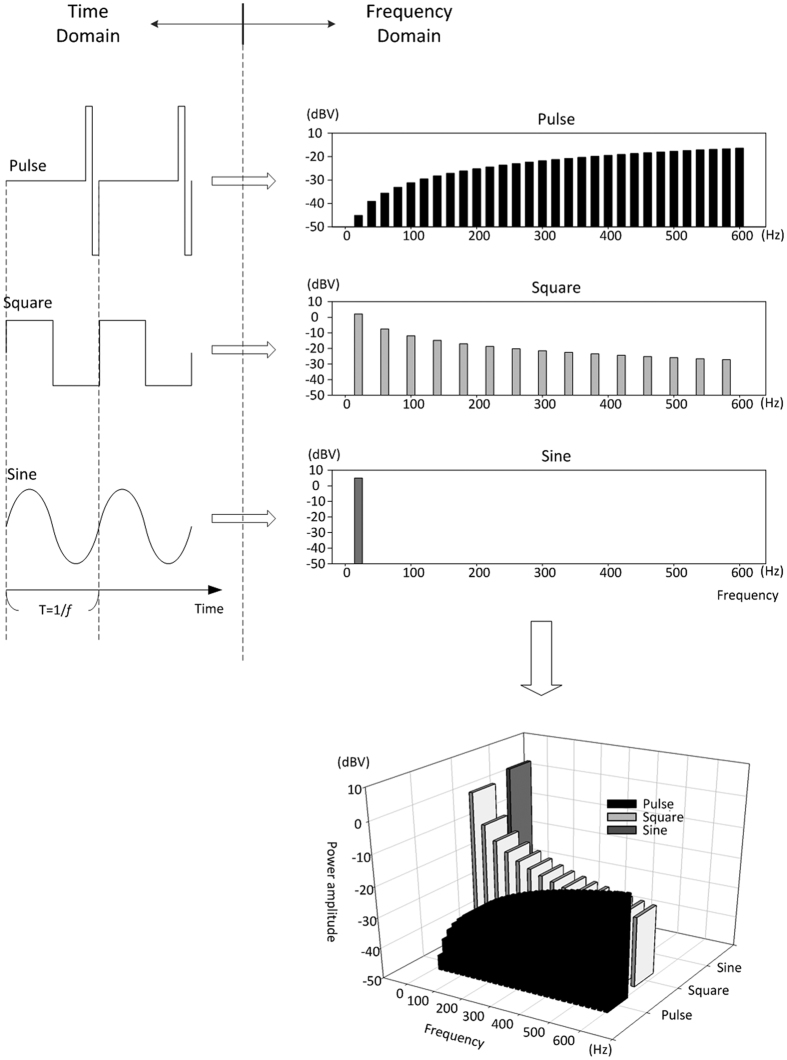
Harmonic analysis of pulse (pulse width = 250 μs, biphasic), square, and sine functions applied at the same frequency (20 Hz) but normalized intensities.Intensity of the square function is 1 Ampere, whereas intensities of pulse and sine functions are normalized such that the pulse, square, and sine functions carry the same amount of electrical energy during the same period of time. Please refer to the Supplementary File for a more detailed description of the harmonic analysis.